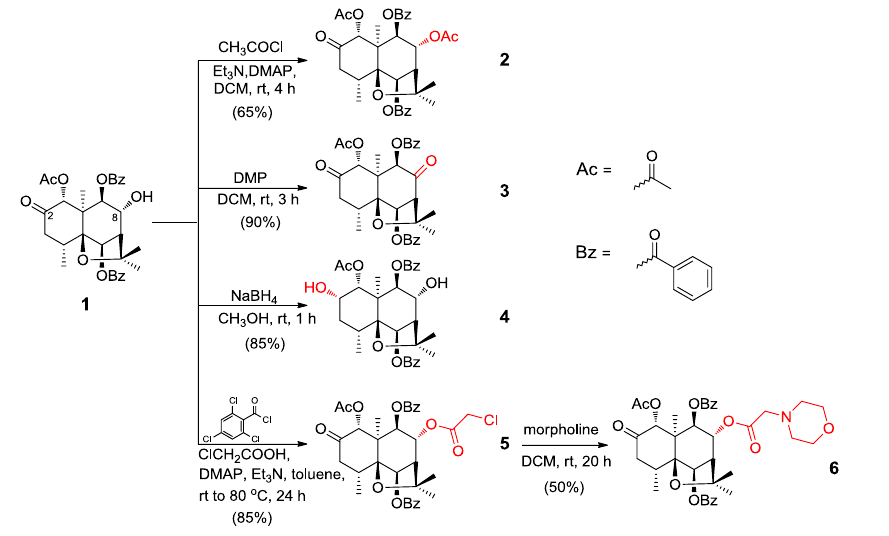
Table 1. 1 H NMR spectroscopic data of compound 2 – 6 (500 MHz, CDCl